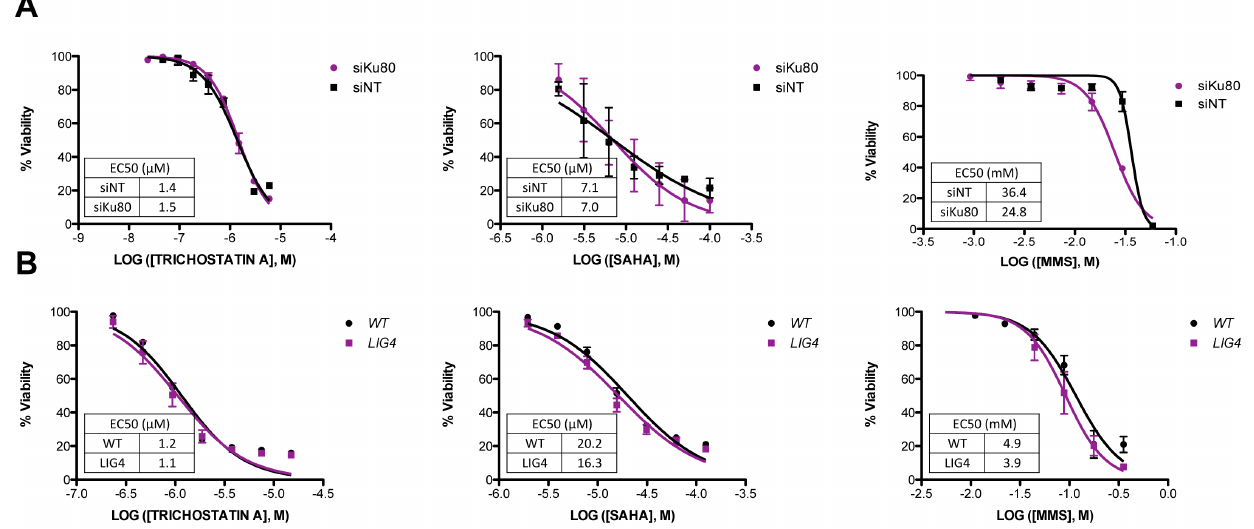
Figure 5. Viability of NHEJ deficient cells after treatment with HDACis. The indicated cells were treated for 48 hr with 0 to 1.5 m M TSA, 0 to 100 m M SAHA or 0 to 118 mM MMS. Viability was determined using CellTiter-Glo. The data represent the average of 3 independent experiments 6 SD. (A) Hela cells after 24 hr transfection with either non-targeting siRNA or siRNA against KU80 . (B) HCT116 LIG4 -null or wild-type HCT116 cells. (C) HCC1937 cells, lacking a functional BRCA1 gene, or HC1937 cells complimented by BRCA1 cDNA expression (wild-type).